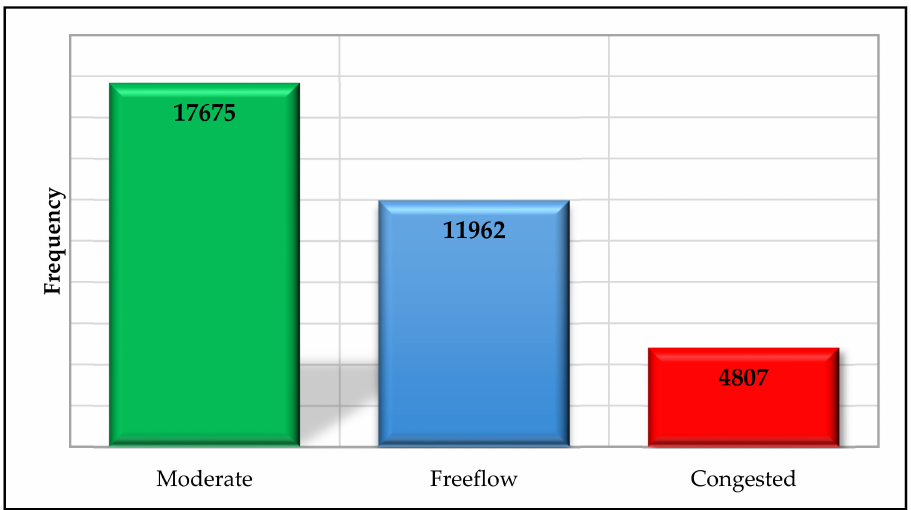
Figure 3. RTC totals per